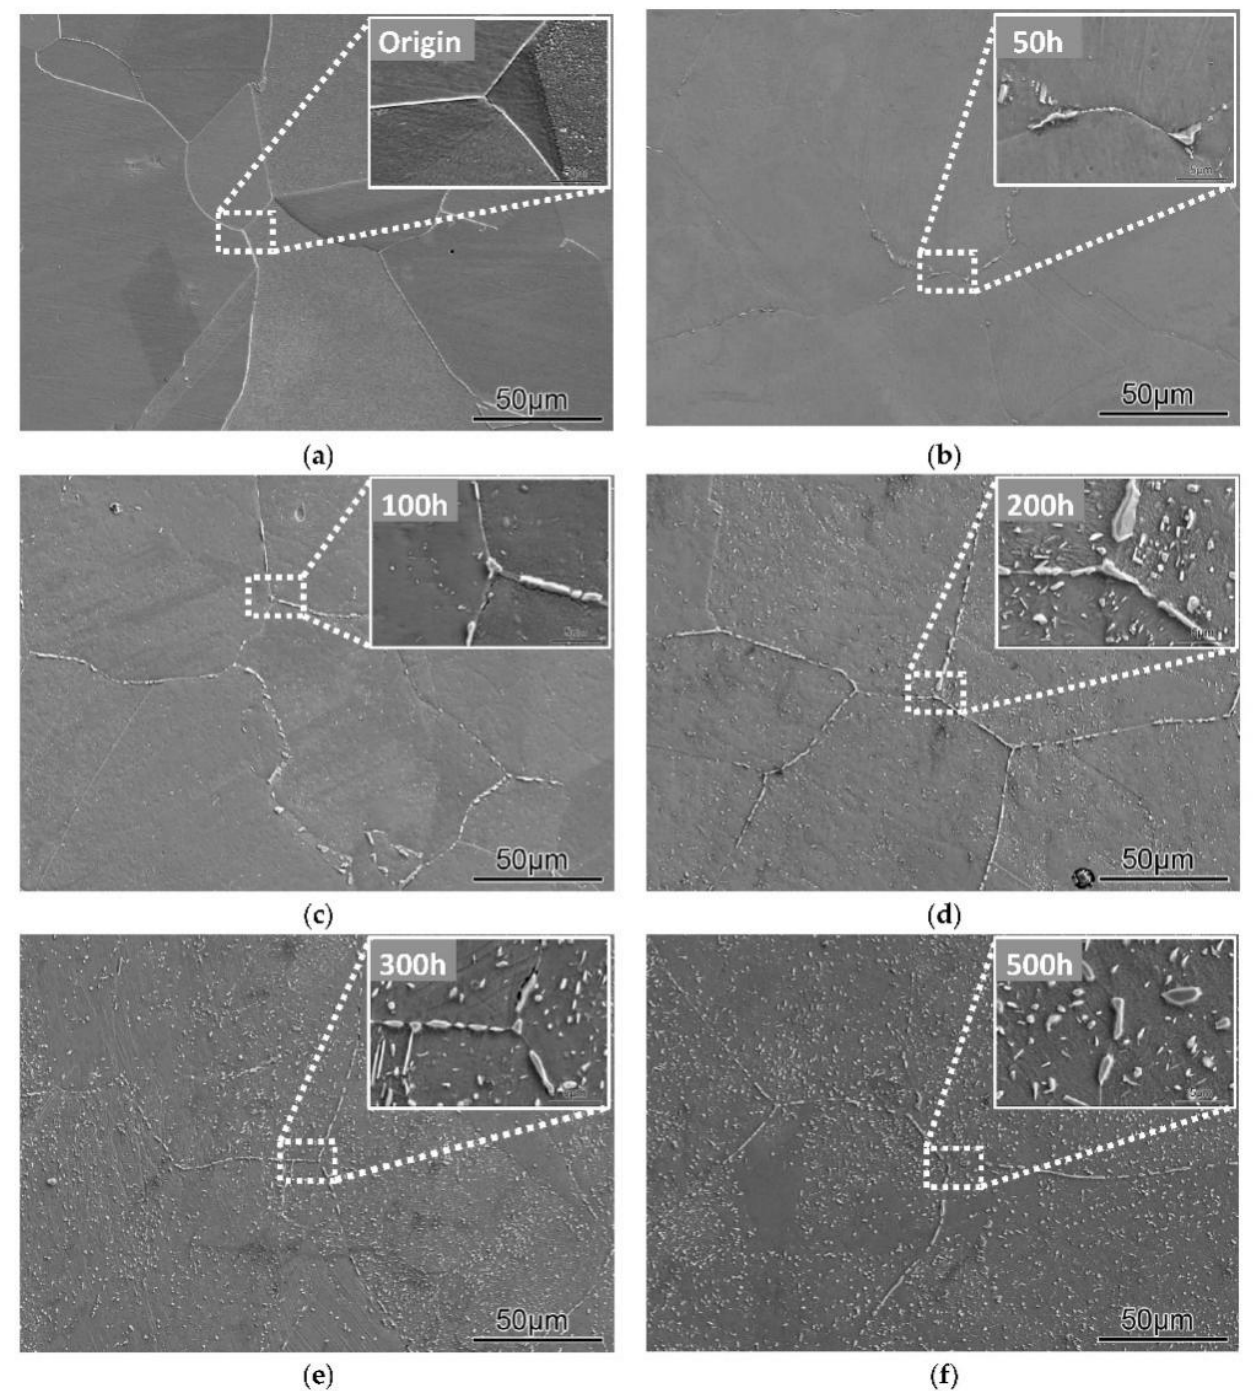
Figure 2. SEM observations of 316 LNSS during thermal aging: ( a ) origin, ( b ) 50 h, ( c ) 100 h, ( d ) 200 h, ( e ) 300 h, and ( f ) 500